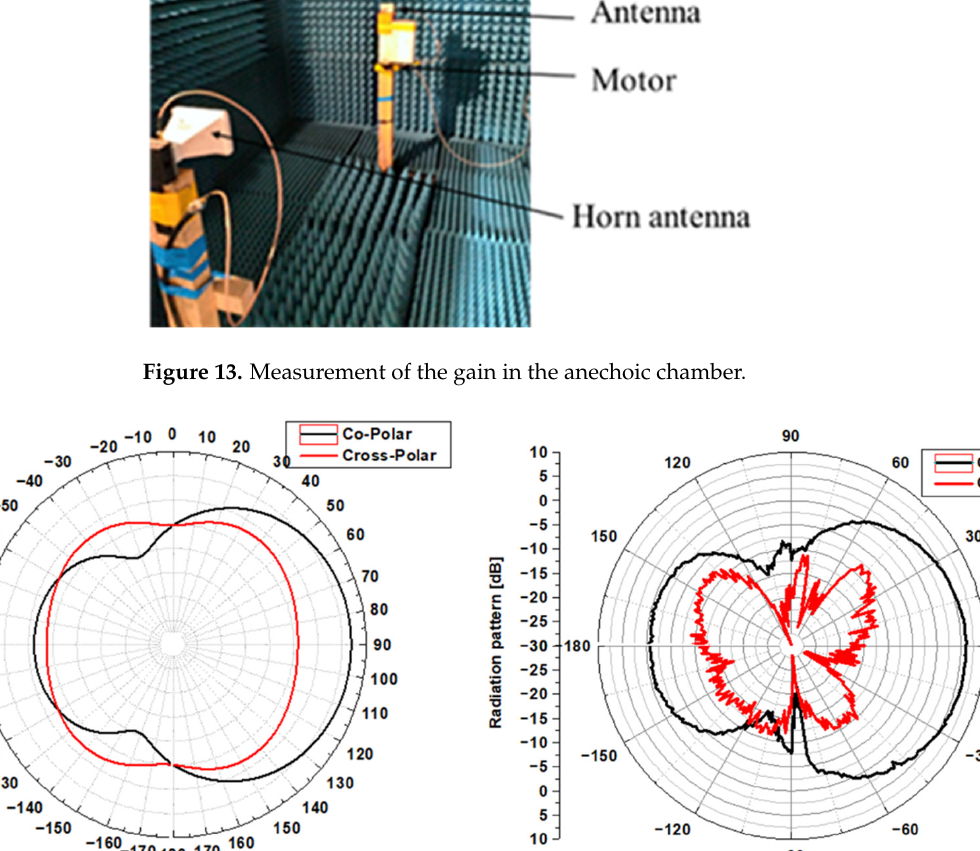
Figure 14. Radiation patterns result in E-plane (phi = 90°) and H-plane (phi = 0°) at 5 GHz in terms of ( a ) simulation results and ( b ) experimental results.